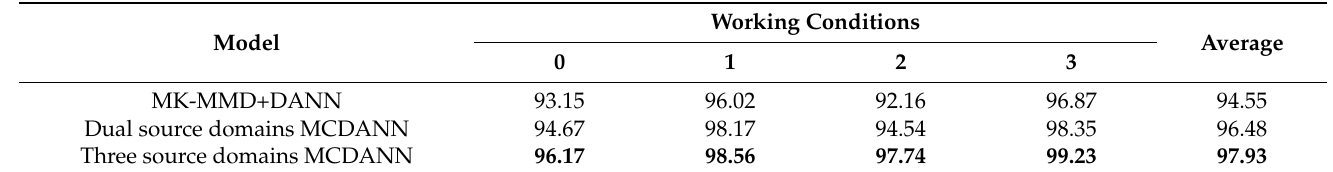
Table 6. Classification accuracy of cross-domain models with different number of source domains under cross-working